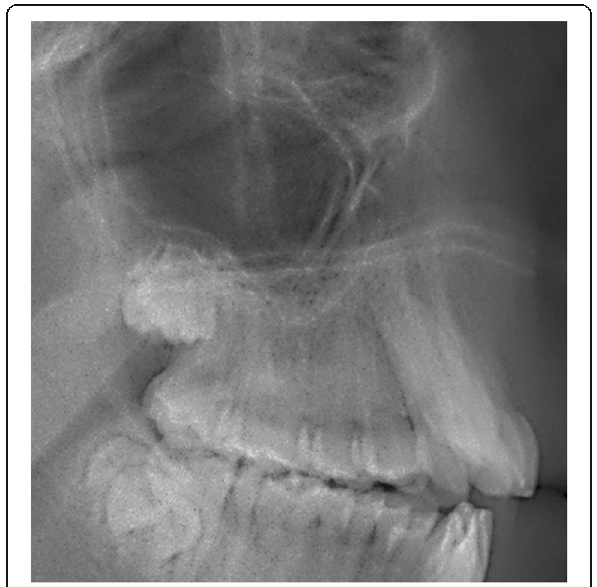
Fig. 1 Example of MPDD. The third molar was potentially blocked